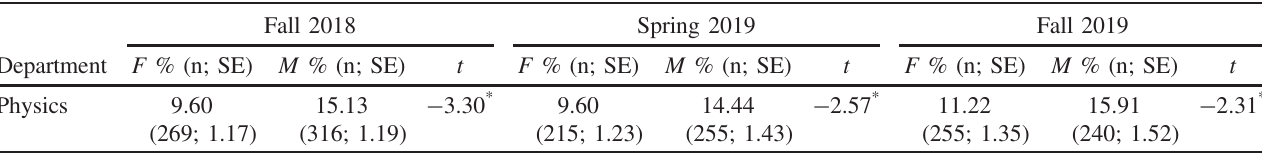
Note : Percentages indicate the proportion of class sessions that students perceived themselves individually and verbally participating.